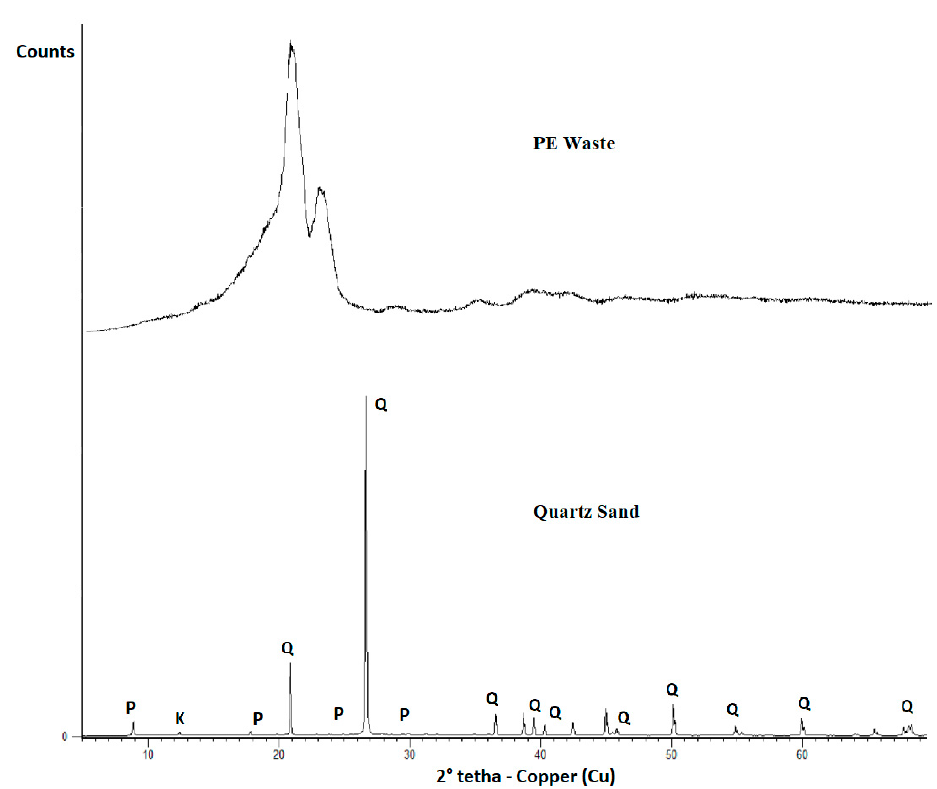
Table 2. Chemical composition of the quartz sand. Chemical Composition